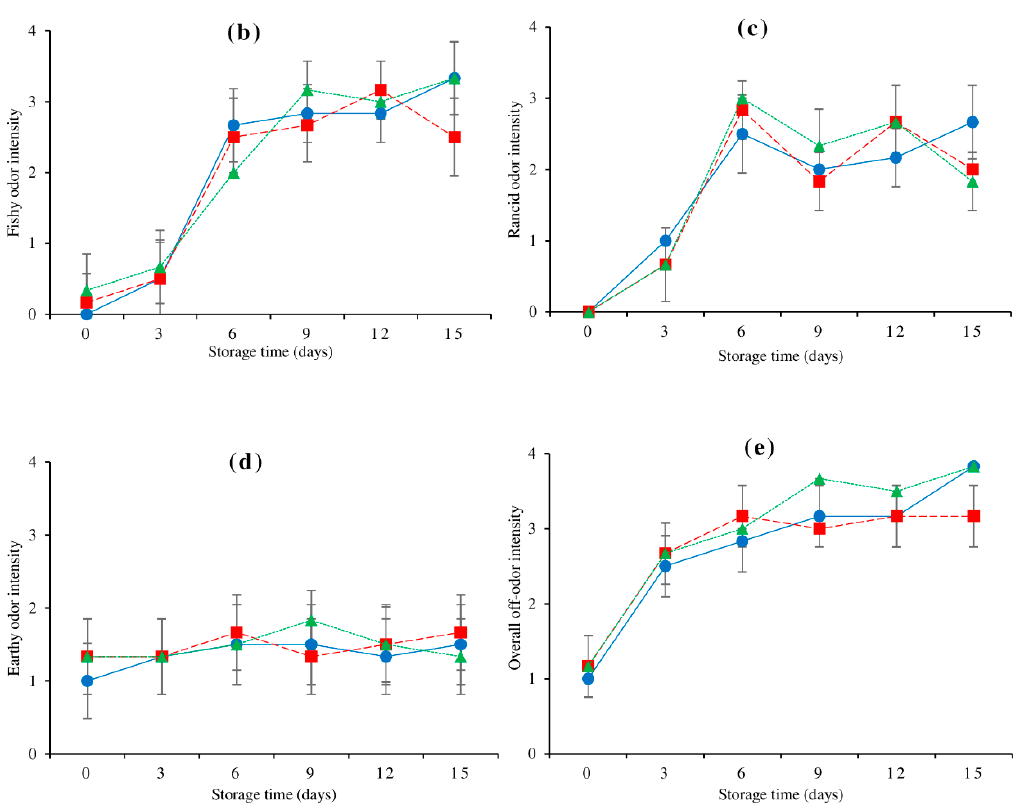
Figure 5. Changes in spoiled odor ( a ), fishy odor ( b ), rancid odor ( c ), earthy odor ( d ), and overall off-odor ( e ) of farmed hybrid catfish dorsal muscle ( ⎯ ● ⎯ ), lateral line (--- ■ ---), and ventral muscle ( … ▲ … ) during 15 days of refrigerated storage. The bars indicate standard deviation from six determinations.